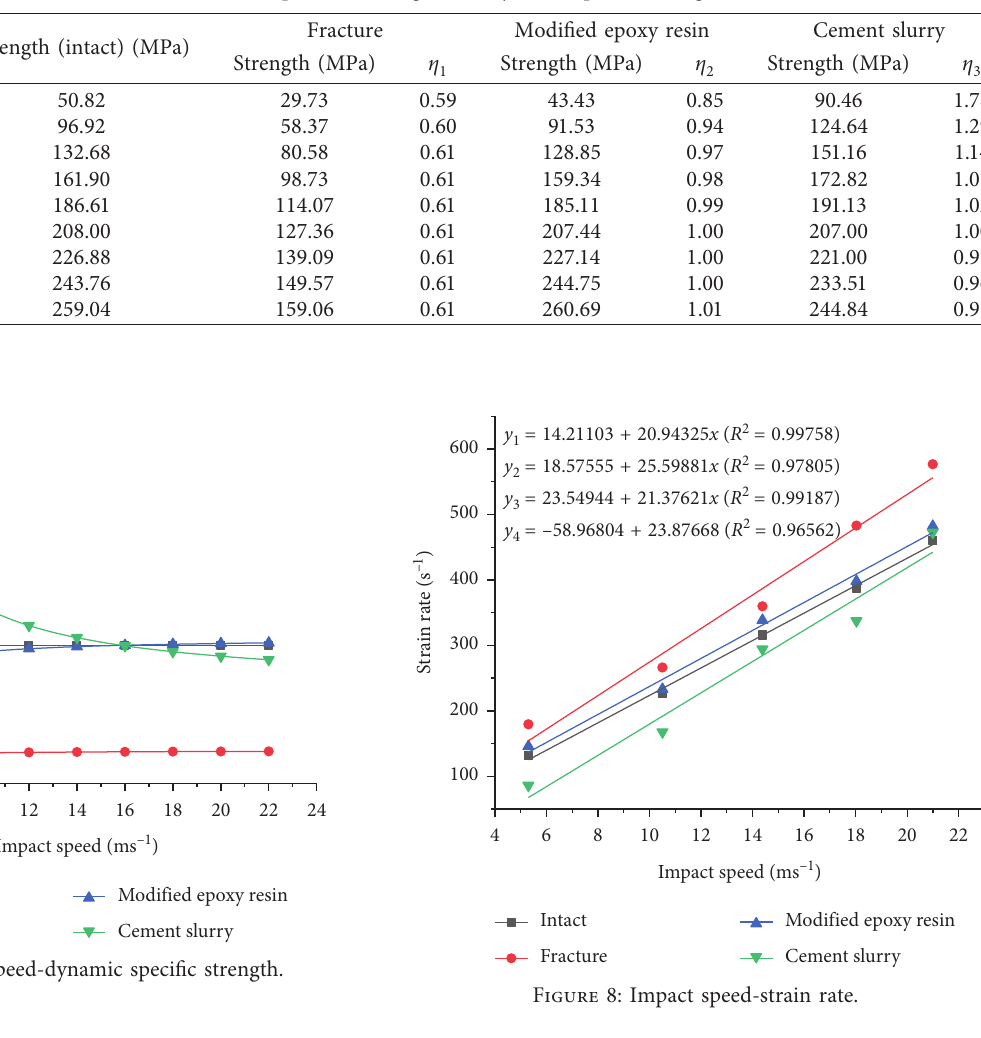
Table 3: Statistical table of specimen strength and dynamic specific